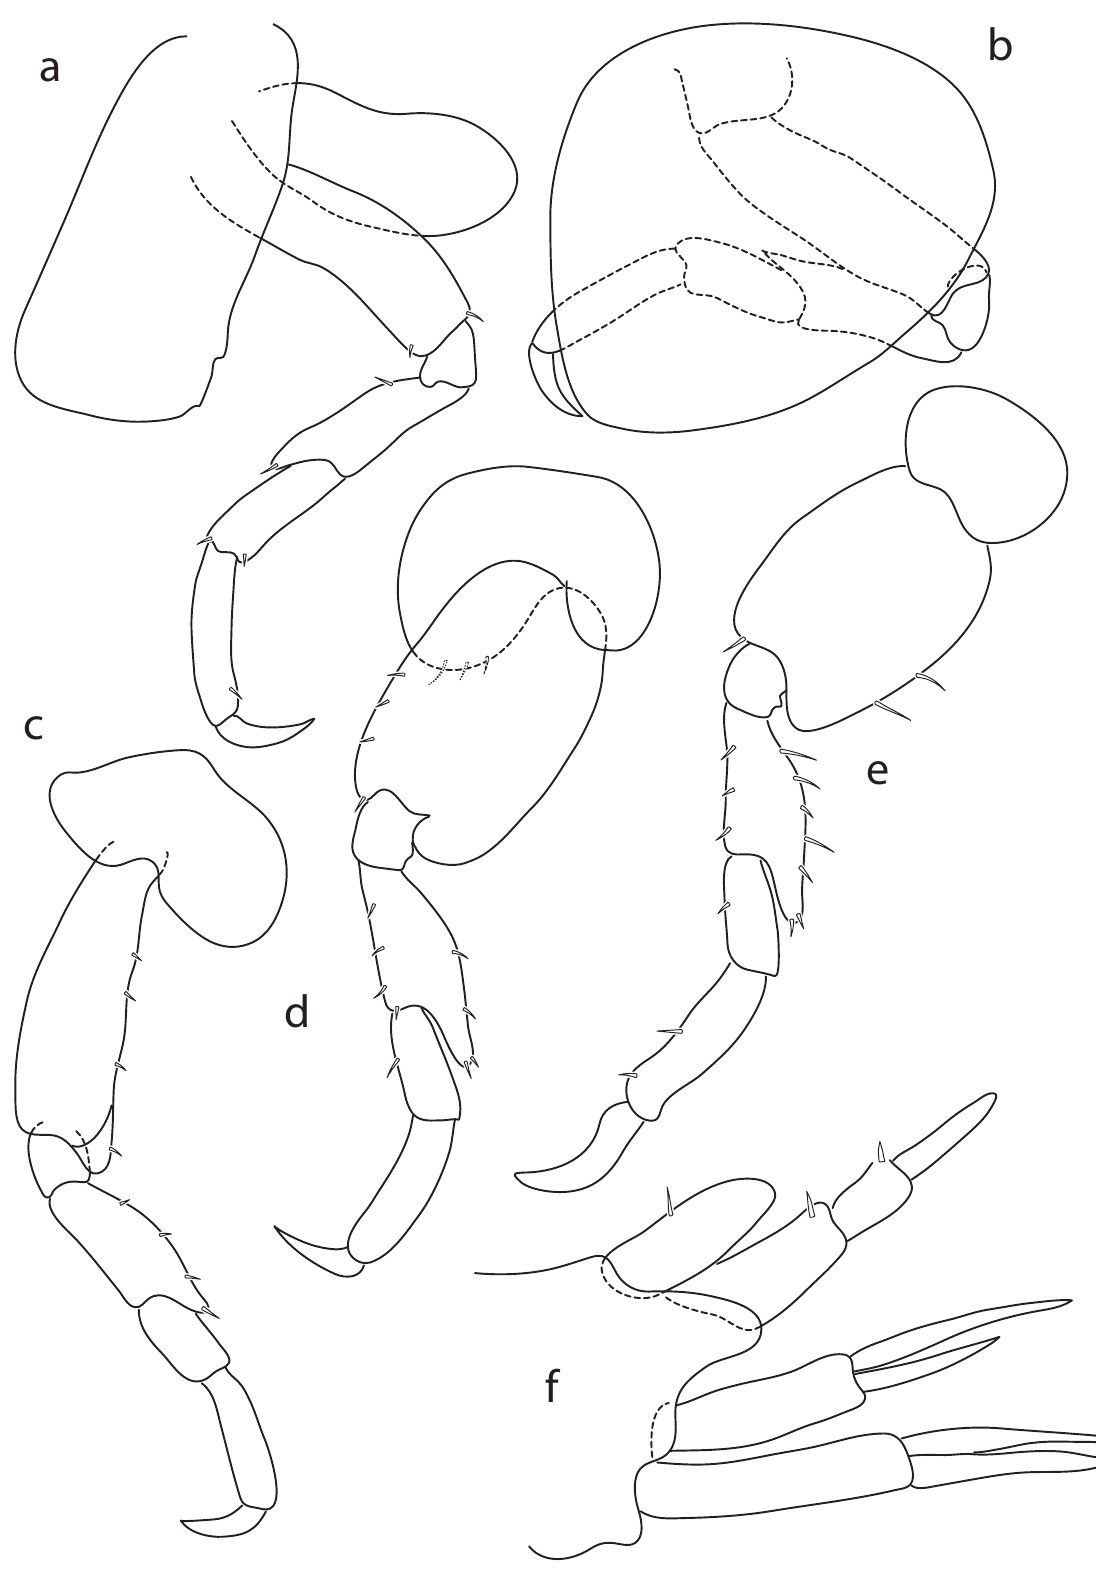
Fig. 28. Torometopa cf. c rassicornis (Schellenberg, 1931) . a . Pereopod 3. b . Pereopod 4. c . Pereopod 5. d . Pereopod 6. e . Pereopod 7. f . Urosome, lateral aspect with uropods 1–3 and telson. Figure not